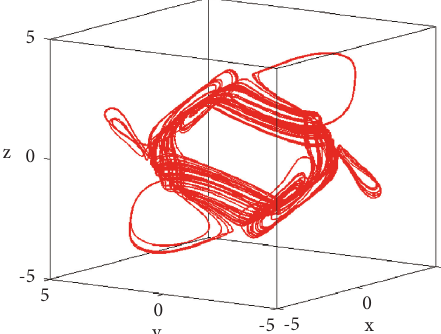
Figure 11: Chaotic attractor of system (4) on 3D projections when q � 0 . 87 and q 3 and b � − 9 and the IC ( x